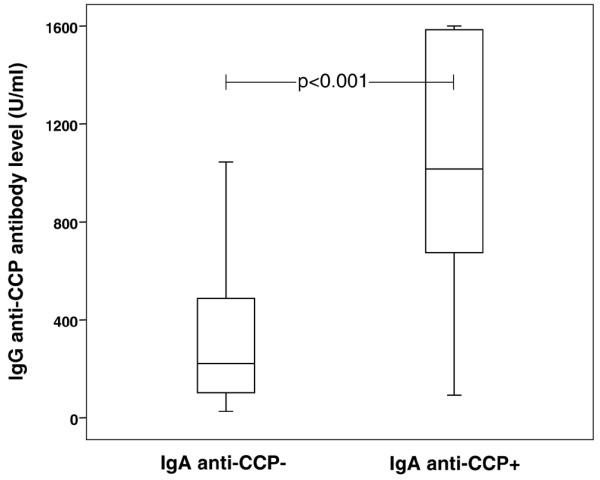
IgG-class antibody levels (median/75-percentiles) in IgG-positive patients with and without IgA-class antibodies against cyclic citrullinated peptides. Box plots illustrating the median IgG-class antibodies against cyclic citrullinated peptides (IgG anti-CCP) levels as well as the 75th percentiles and total ranges among the IgG-positive patients with positive IgA-class antibodies against cyclic citrullinated peptides (IgA anti-CCP) tests.